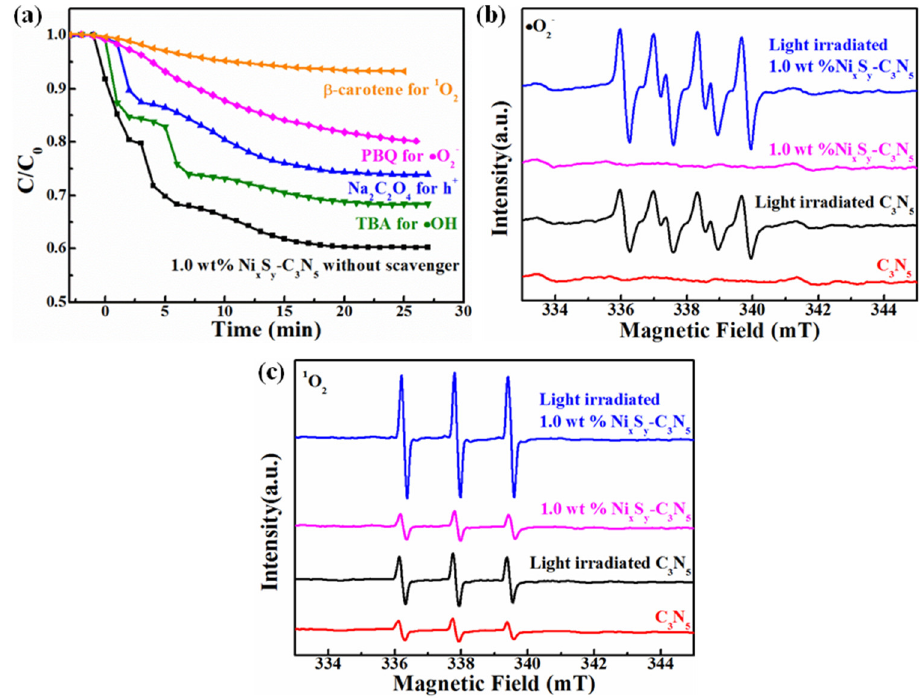
Figure 9. ( a ) Trapping agent experiments for photocatalytic NO removal. ESR spectra of DMPO- • O 2 −